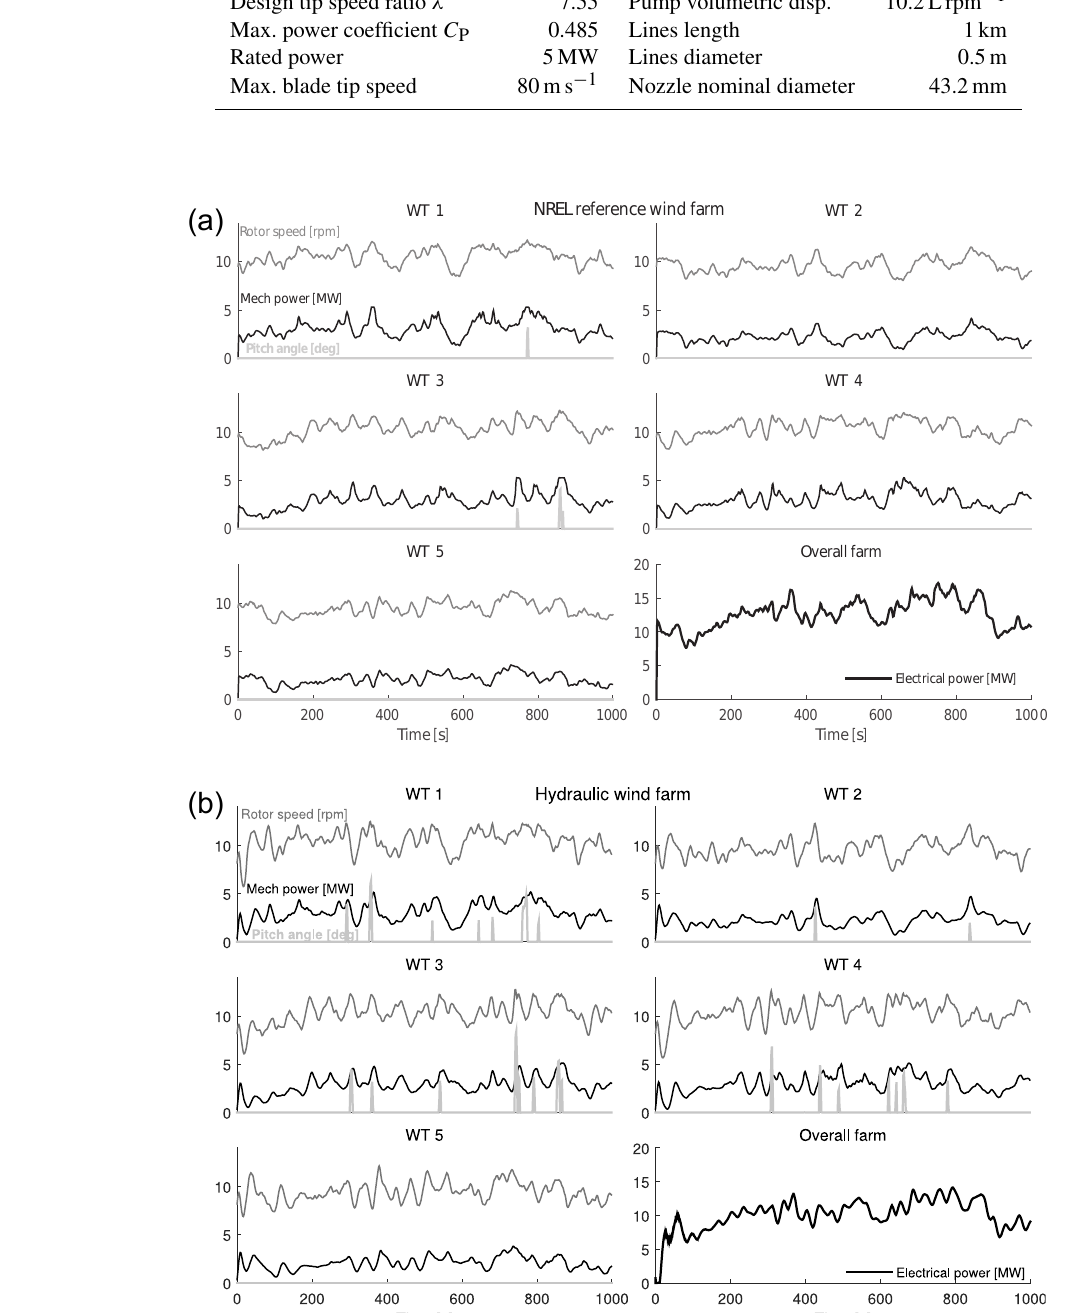
Figure 12. Time domain results for a wind farm comprising of five turbines subject to a wind field with a mean speed of 9ms − 1 and 10% turbulence intensity. (a) Reference wind farm, below rated conditions. (b) Hydraulic wind farm, below rated